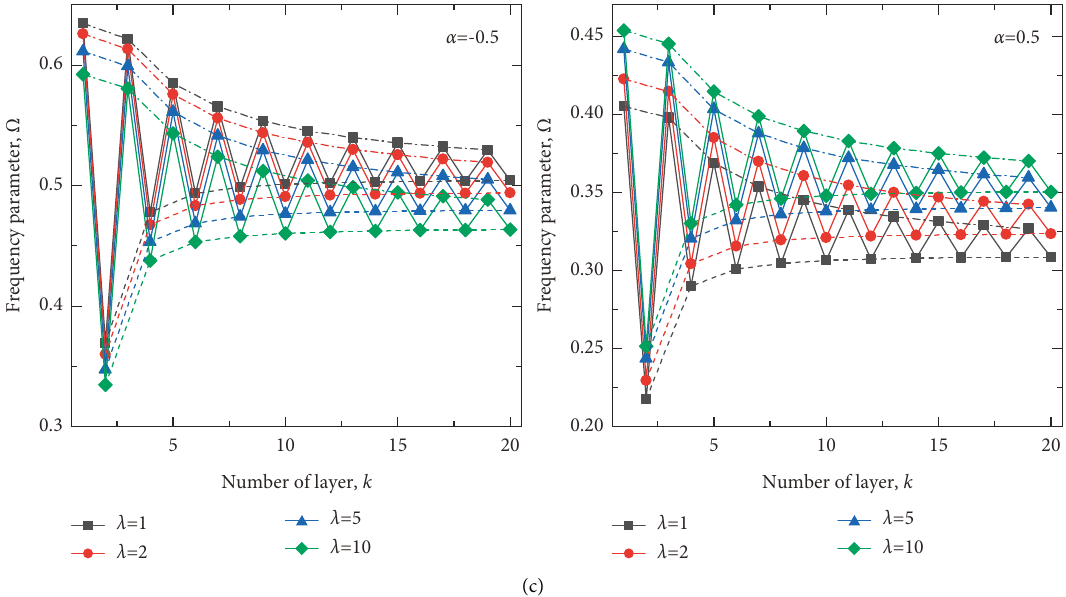
Figure 8: Variation of the frequency parameter according to lamina number k for [0 ° /90 ° ]k laminated composite structures with C–C boundary condition and variable thickness( n � 1, m � 1): (a) conical shell, (b) cylindrical shell, and (c) annular